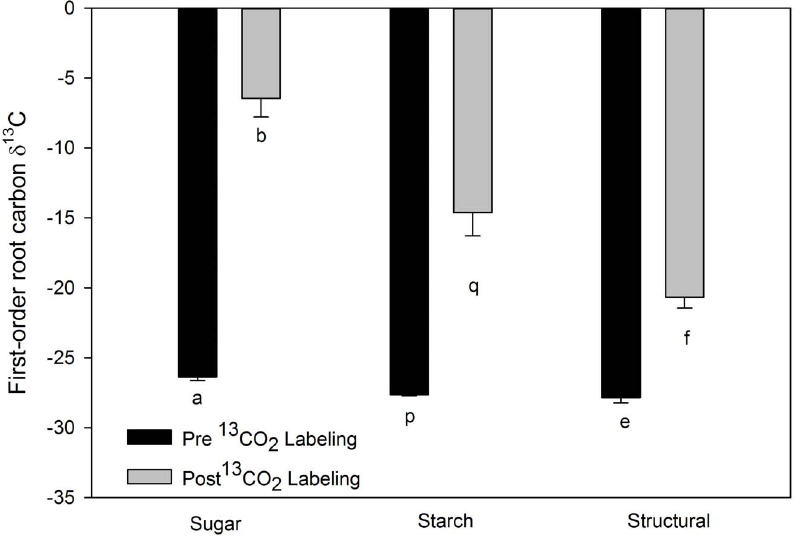
Figure 5. Mean Sassafrasalbidum first-order root carbon d 13 C values. Roots were at least two weeks old at the time of whole tree labeling in 2009. Black bars represent roots that were sampled immediately prior to whole-tree labeling. Light grey bars represent roots sampled after whole- tree labeling. Note that less negative values indicate greater isotopic enrichment. Error bars denote standard error. Different lower case letters denote significant differences at P # 0.05 using a one tailed T-test between pre- and post-labeled roots of each tissue type.